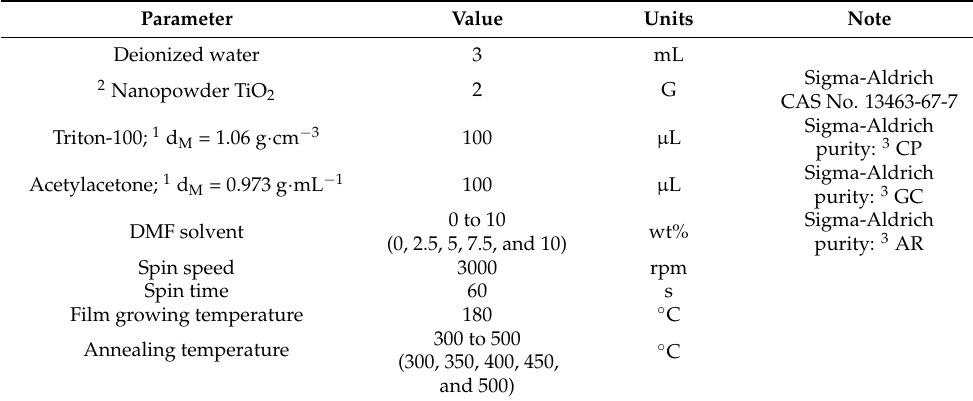
Table 1. The preparation parameters for the TiO 2 solution and its film